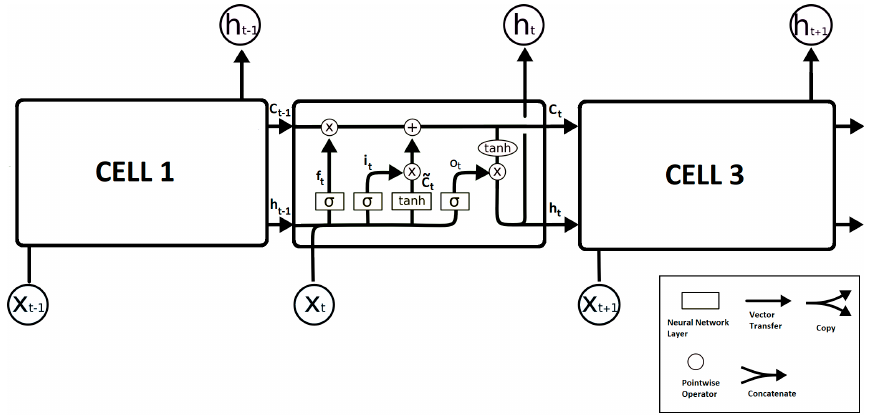
Figure 1. Structure of an LSTM network, where LSTM cells are linked as a chain. For each LSTM cell, x and h are the input and output, respectively.